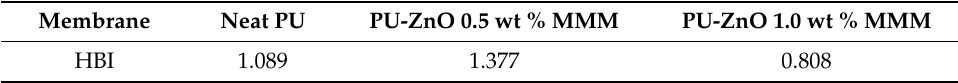
Table 3. Hydrogen bonding index (HBI) amounts of PU